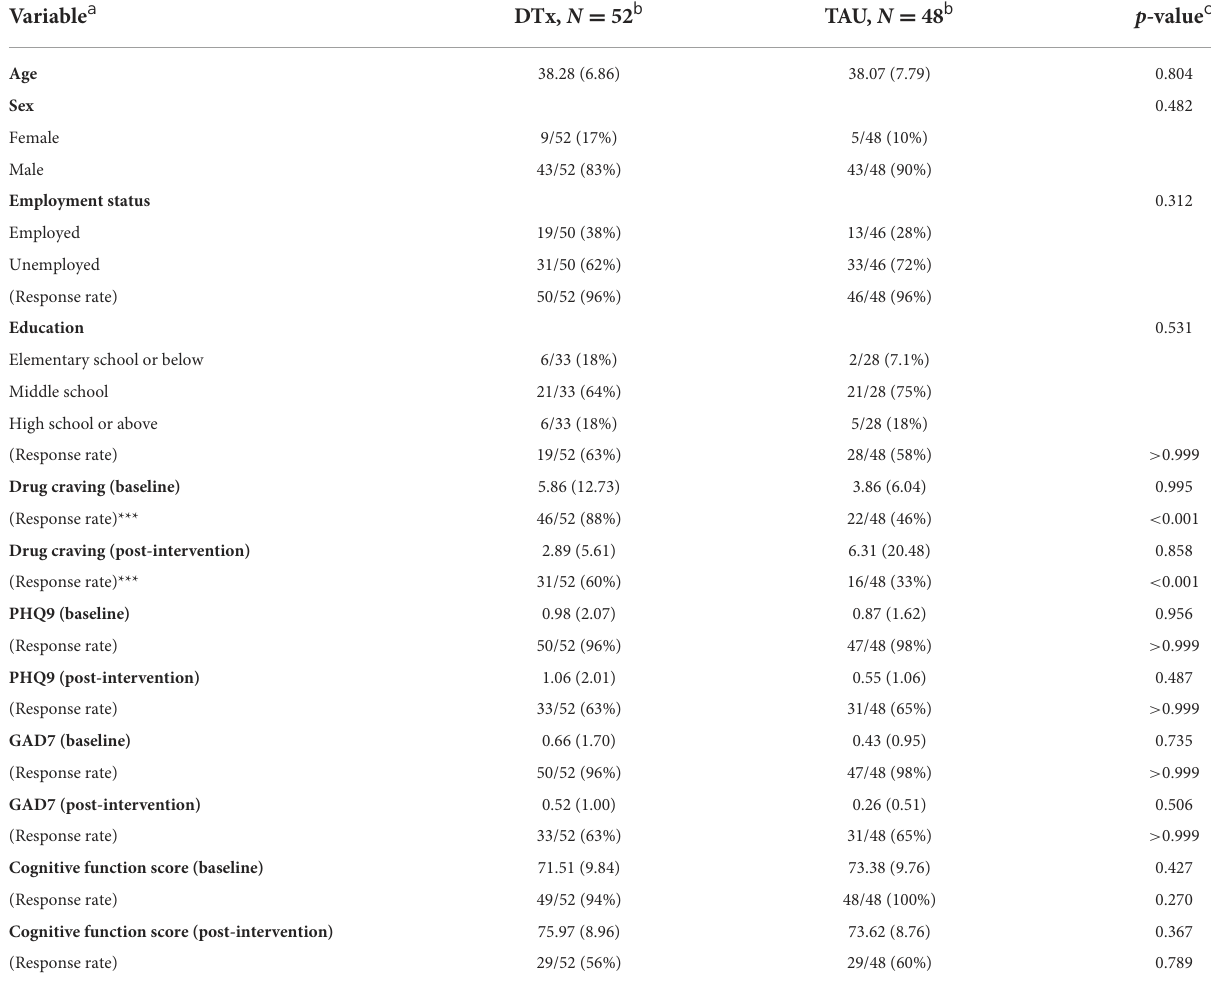
TABLE 1 Participant characteristics and response